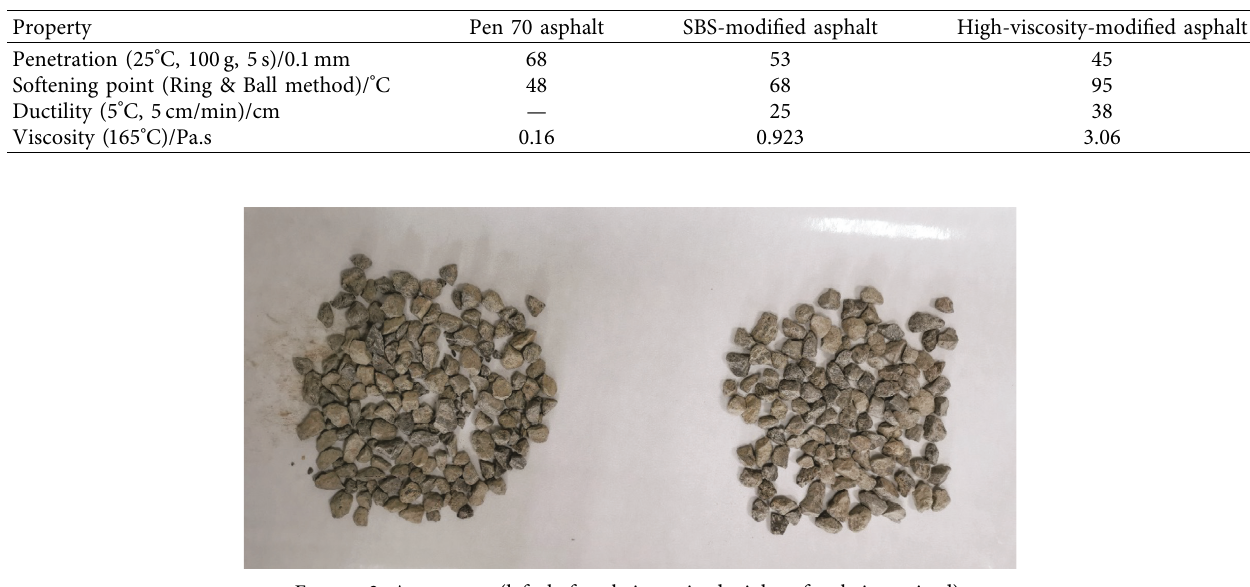
Figure 1: Research flowchart. Table 1: Basic properties of asphalt binders.